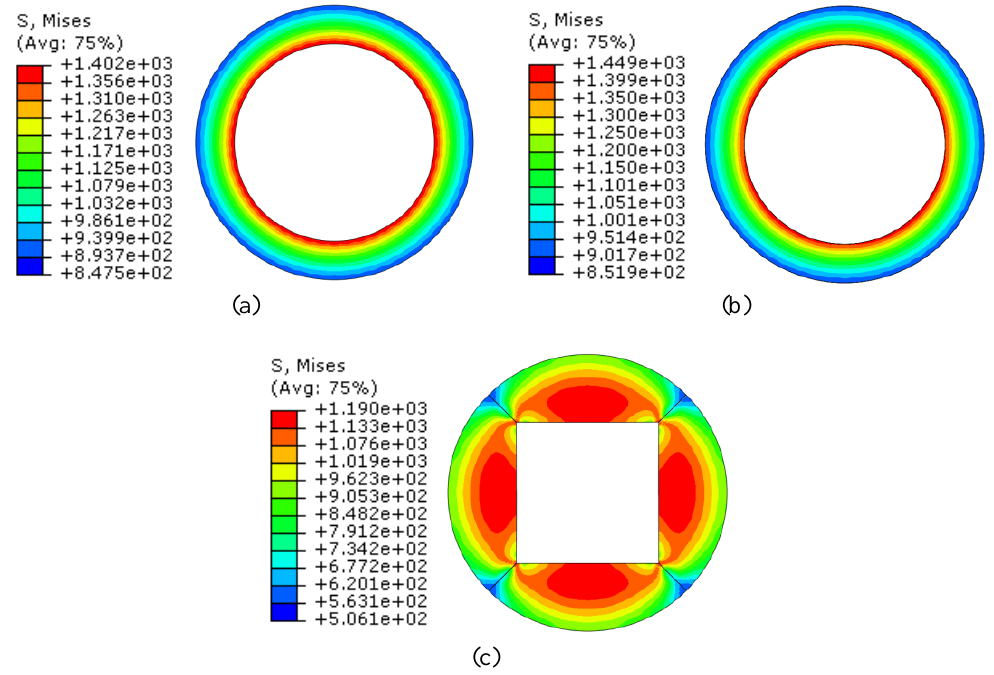
Figure 5. Von Mises stress distributions of first layer supporting rings: ( a ) BTD; ( b ) SLSD; and ( c ) DLSD.